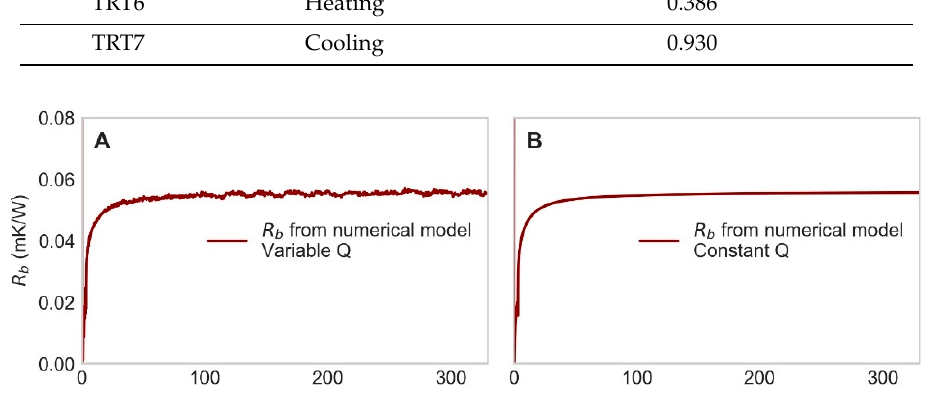
Figure 6. Forward simulation of all TRTs.